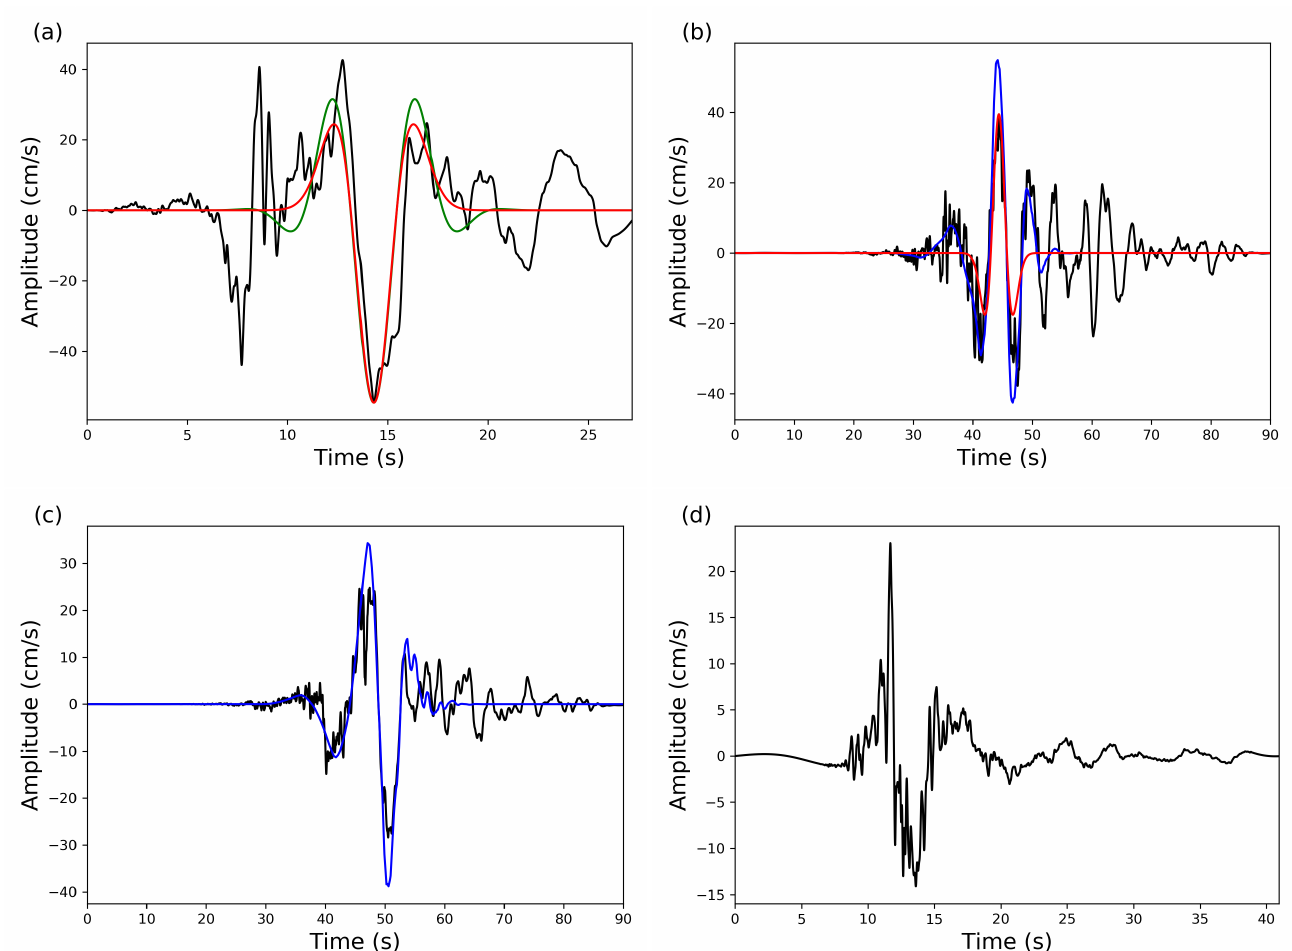
Figure 2. ( a ) Velocity waveform (black) of the radial component of Düzce station ( R jb = 13.6km) in the 17th of August 1999 Kocaeli, Turkey earthquake ( M w = 7.5); ( b ) velocity waveform of the radial component of TCU038 station ( R jb = 25.4km) in the 20th of September 1999 Chi-Chi, Taiwan, earthquake ( M w = 7.6); ( c ) velocity waveform of the transverse component of TCU026 station ( R jb = 56.0km) in the Chi-Chi, Taiwan earthquake; ( d ) velocity waveform of the radial component of 4809 station ( R jb = 7.8km) in the 21st of July 2017 Aegean Sea earthquake ( M w = 6.5). Green, red, and blue wavelets are fitted wavelets determined by Shahi and Baker [9], Chang et al. [22], Ertuncay and Costa [23],